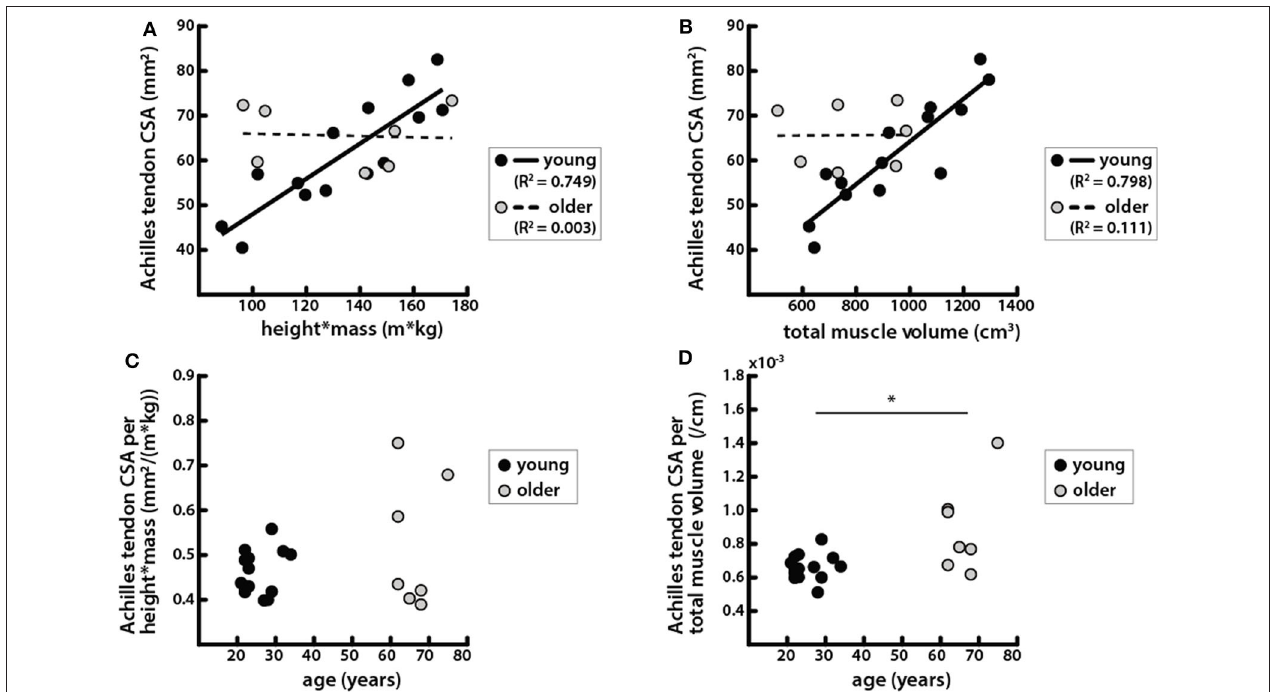
FIGURE 5 | Achilles tendon CSA was correlated with body and muscle size in young adults but not in older adults. (A) Achilles tendon CSAs vs. the product of height and mass in young (black circles, solid line: R 2 = 0.749, p = 6.42e − 5) and older (gray circles, dashed line: R 2 = 0.003, p = 0.901) adults. (B) Achilles tendon CSA vs. total triceps surae muscle volume in young (black circles, solid line: R 2 = 0.798, p = 1.69e − 5) and older (gray circles, dashed line: R 2 = 0.111, p = 0.139) adults. (C) Achilles tendon CSA normalized by height * mass vs. age; a Mann-Whitney rank sum test determined that there were no significant differences between age groups in tendon CSA normalized by body size ( p = 0.737). (D) Achilles tendon CSA normalized by total triceps surae muscle volume vs. age; a Mann–Whitey rank sum test determined that tendon CSA normalized by muscle size was significantly different between young and older adults ( p = 0.019). *Indicates significant difference between young and old